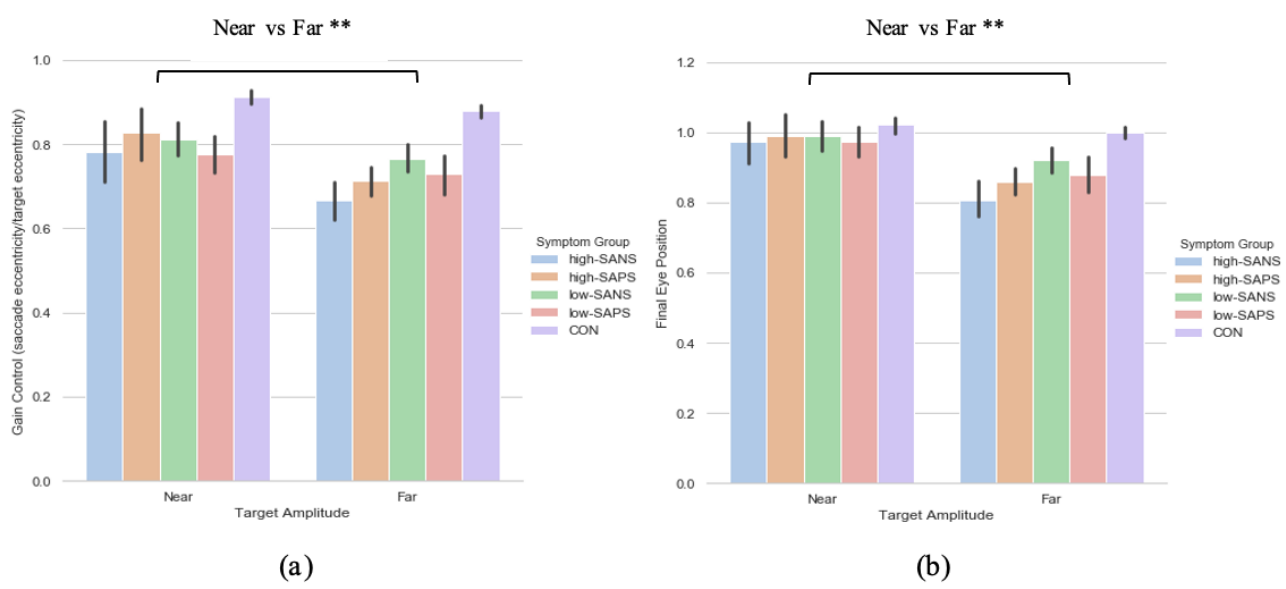
Figure 3. A comparison of performance in the ( a ) gain and ( b ) final eye position measures between the two target eccentricities based on their negative and positive symptoms. ** Refers to significance at the p < 0.01 level. Error bars refer to standard error.